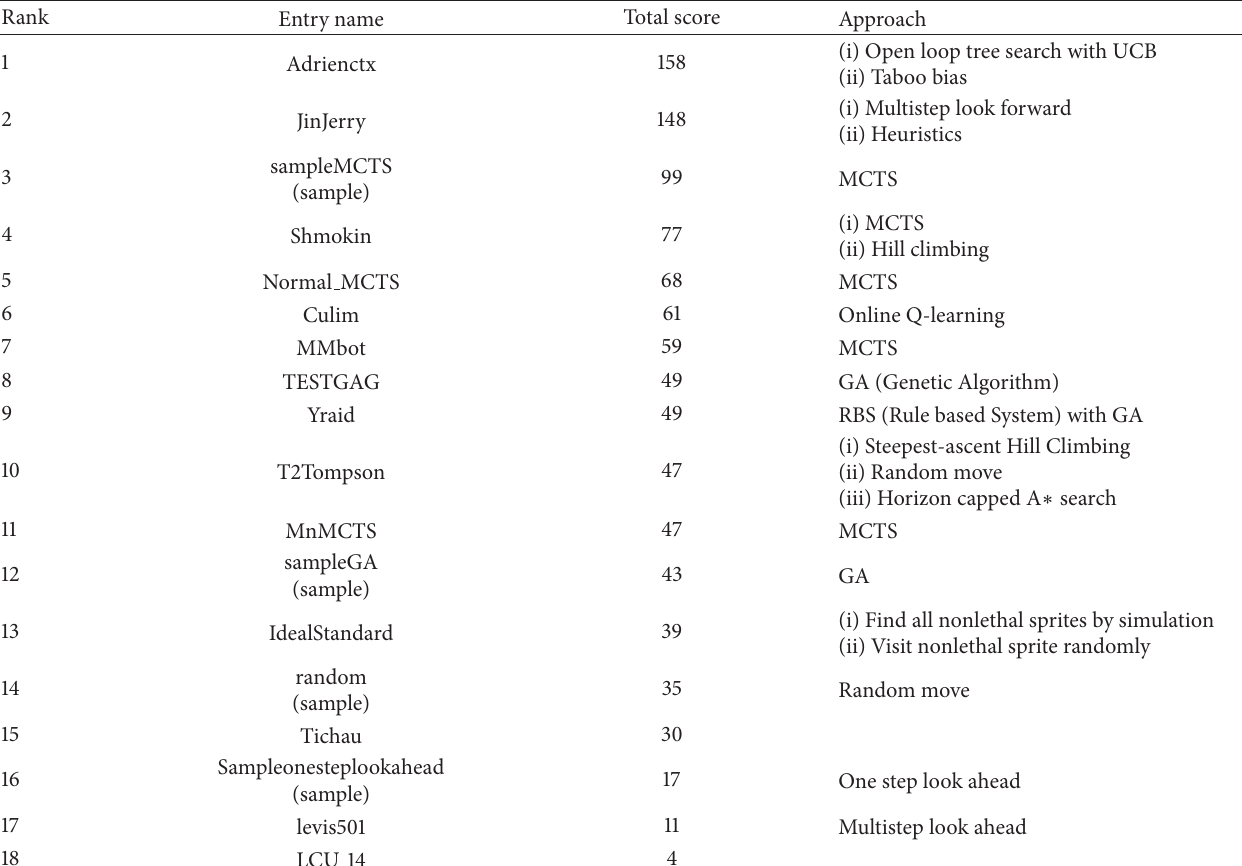
Table 3: Summary of entries in the IEEE CIG 2014